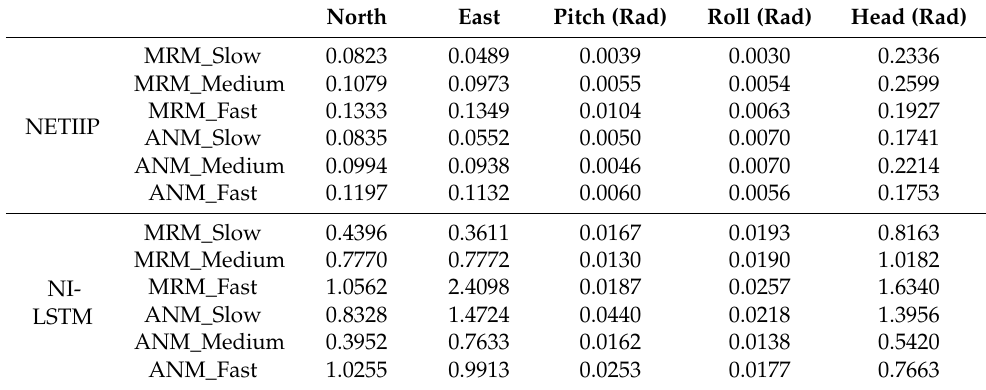
Table 2. RMSE coefficients of different models and different predictions.